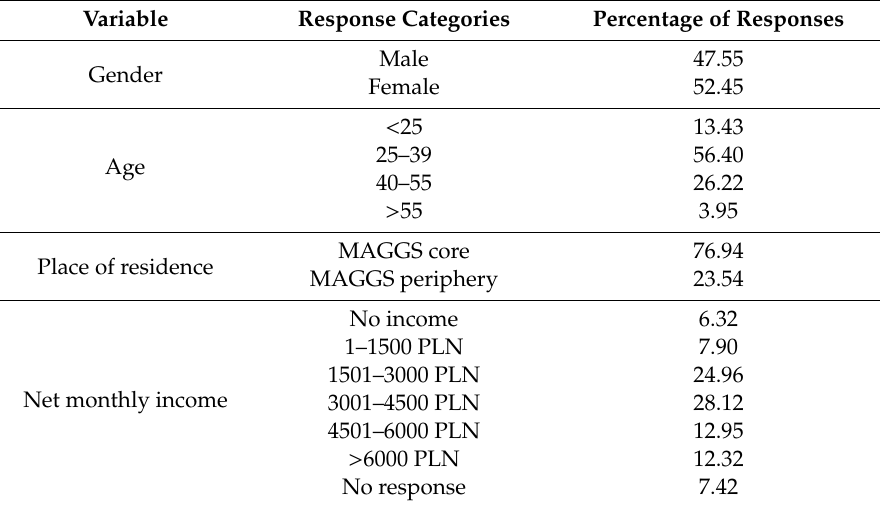
Table 1. The sociodemographic structure of the sample.